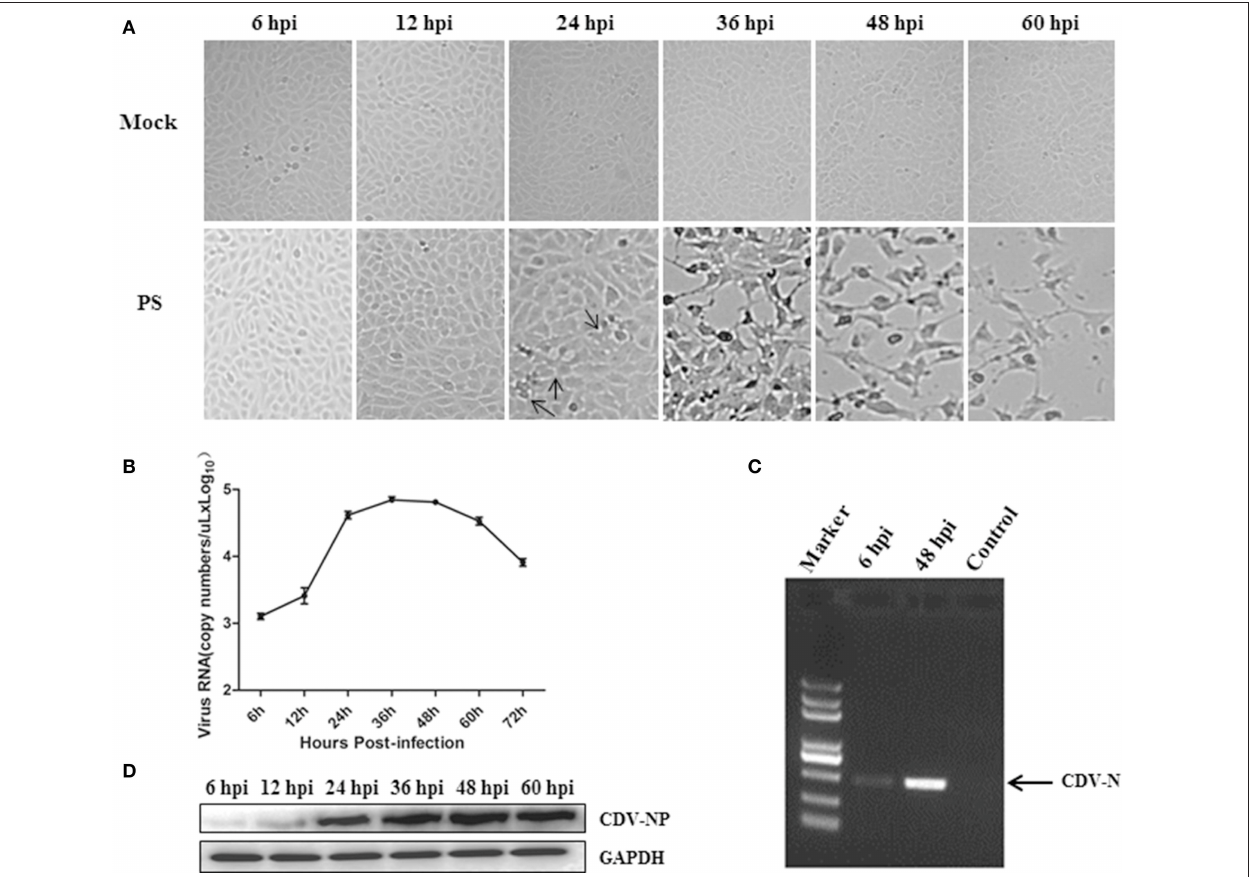
FIGURE 1 | Confirmation of PS infection in Mv.1.Lu cells. (A) Photomicrographs of Mv.1.Lu cells infected with PS (MOI = 2) or mock-infected at different time-points. Images were taken at an original magnification of 20 × . The CPEs of cells detachment at 24 hpi were pointed by the arrows. (B) One-step growth curve of CDV strain PS in Mv.1.Lu cells. (C) RT-PCR validation of PS infection in Mv.1.Lu cells by amplifying the CDV-N gene. (D) Western blot analysis of the nucleoprotein of PS in tested time points using anti-NP